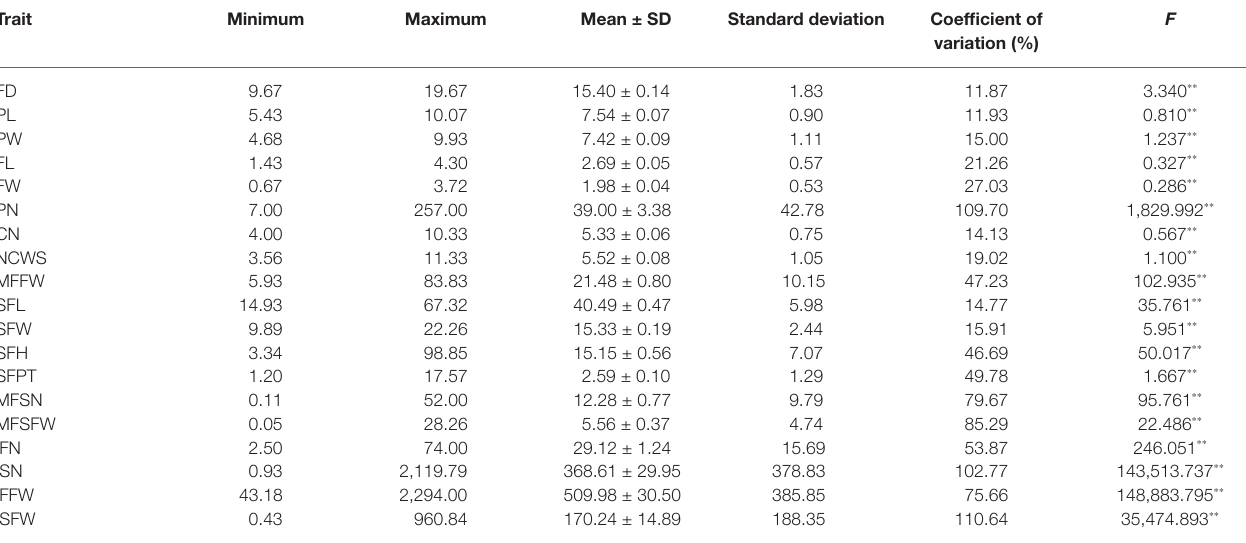
TABLE 1 | Descriptive statistics of 19 quantitative traits in 160 flare tree peony (FTP) accessions. Trait Minimum Maximum Mean ± SD Standard